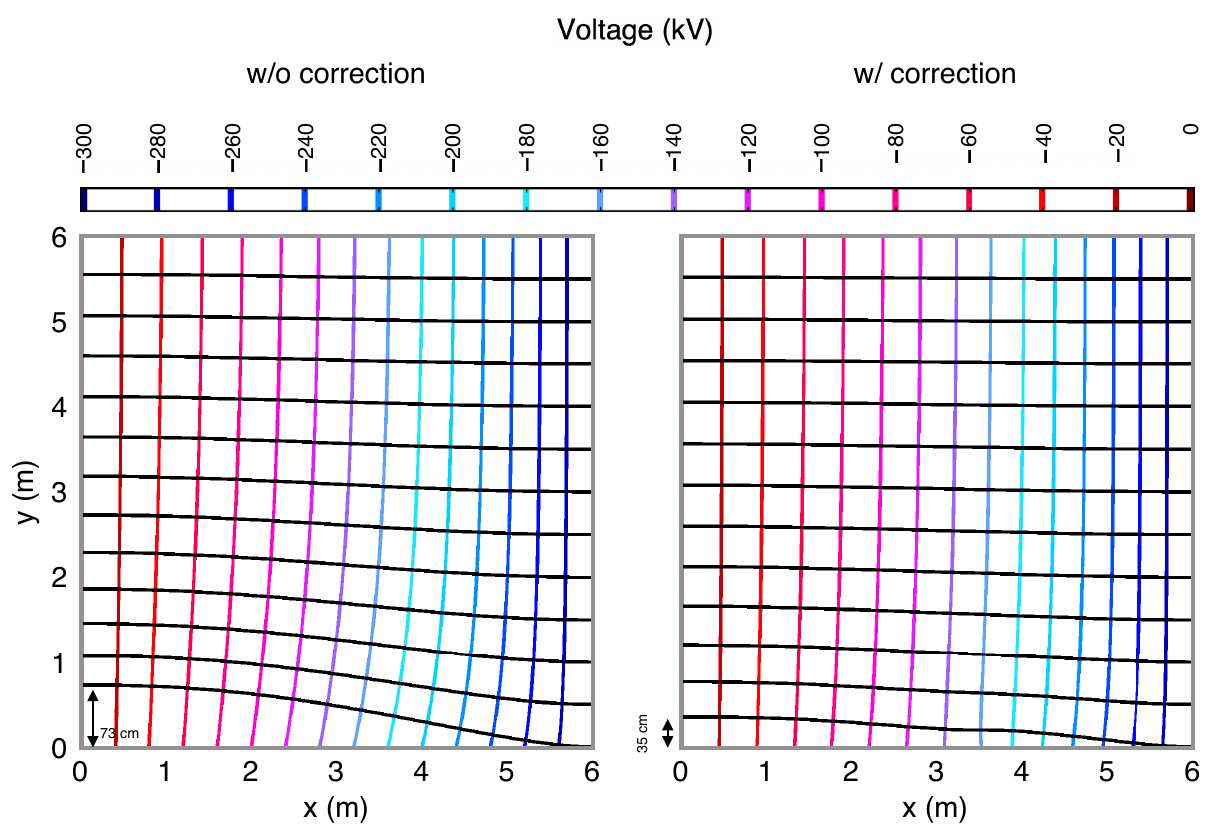
Figure 7. Contours of equal voltage V ( x , y ) and drift paths, with a usual voltage gradient at the field cage ( left ), and with a third voltage connection at x = 3.5 m, as discussed in the text ( right ). The anode is at x = 0, the cathode at x = 6 m and the field cage at y = 0. Reproduced from reference